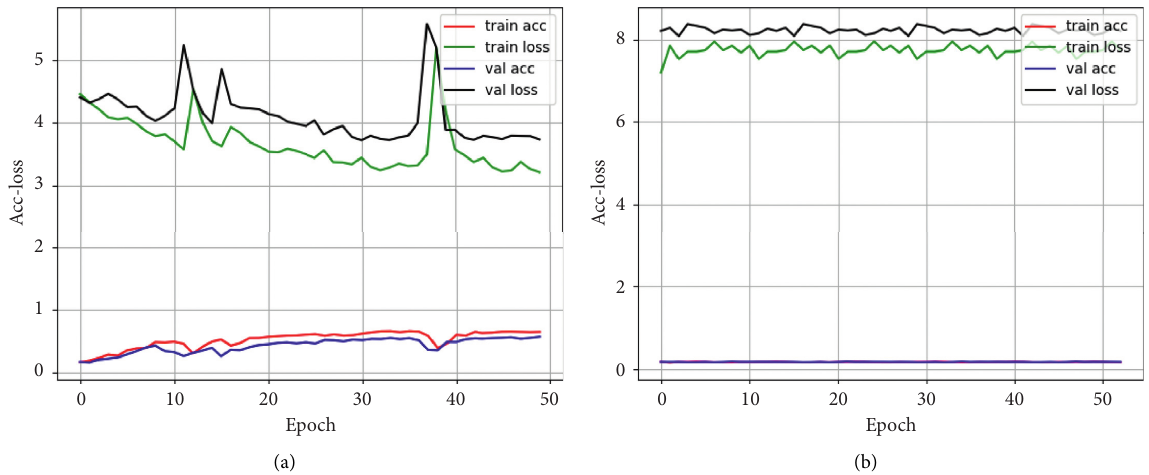
Figure 16: CNN trained by original failure data and CNN trained by all LMD-PFs.